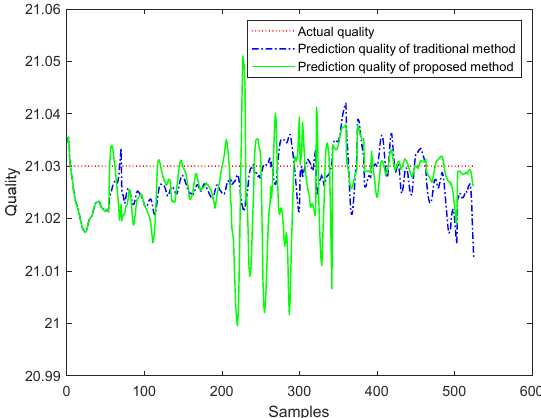
Table 4. RMSE of different prediction method.